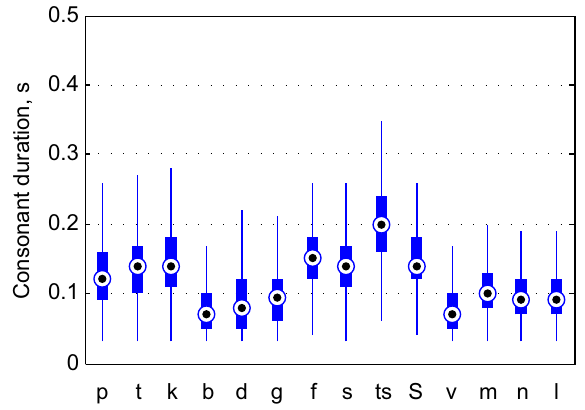
Figure 12. VCV logatomes: duration of central